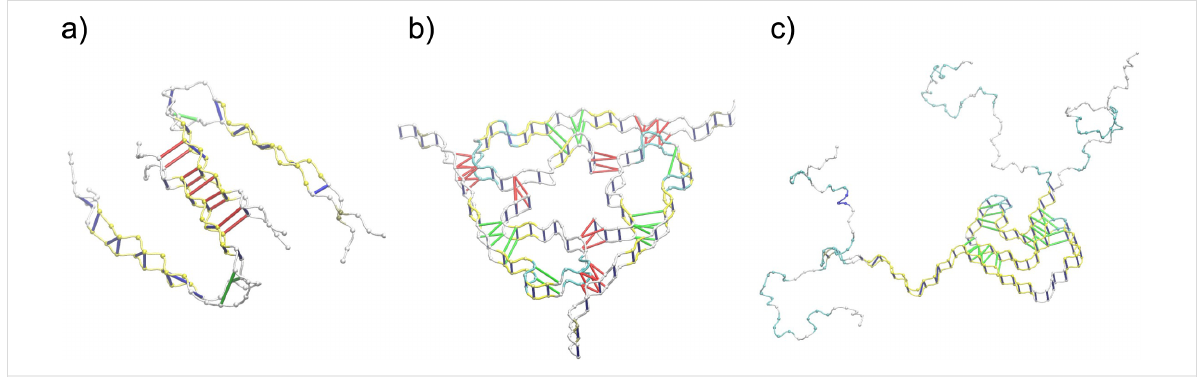
Figure 2: Coarse-grained representation of the biological fibrils presented in Figure 1. Illustrated are the three types of “native contact” interactions considered in our study: i) intrachain contacts (green), ii) interchain contacts (red) iii) intersheet contacts (blue).